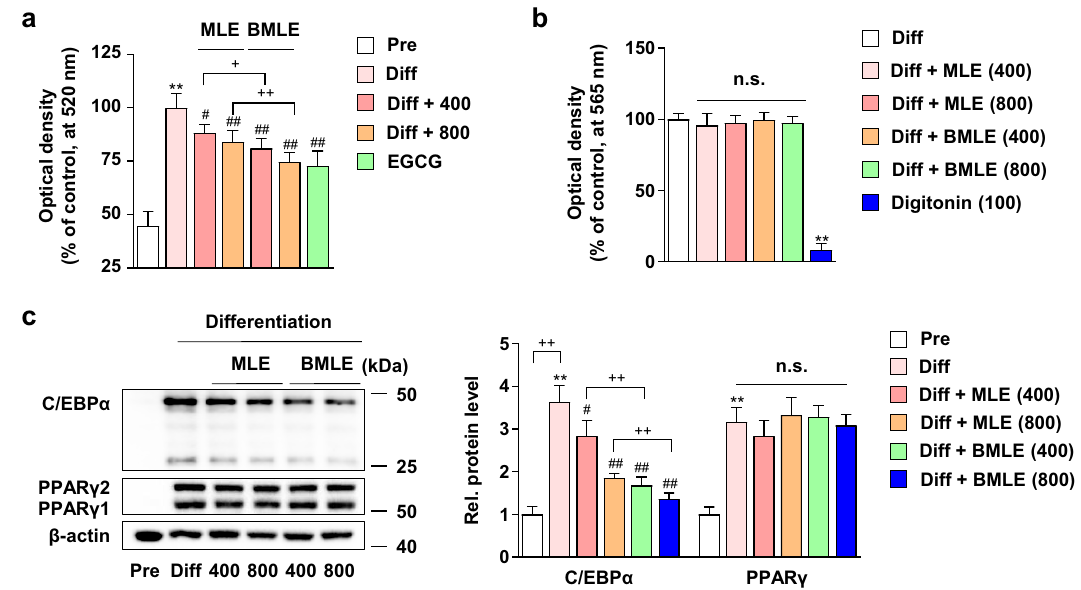
Figure 1. Effects of mulberry leaf extract (MLE) and bioconverted mulberry leaf extract with Pectinex (BMLE) on lipid accumulation, cytotoxicity, and adipogenic factors in 3T3-L1 cells. ( a ) Effects of MLE and BMLE on lipid accumulation in 3T3-L1 cells. MLE (400 and 800 μg/mL), BMLE (400 and 800 μg/mL) or (−)-epigallocatechin gallate (50 μM, EGCG) were treated 3T3-L1 adipocytes during differentiation periods. Oil red O staining was performed as described in the Materials and methods section. Pre: preadipocytes, Diff: 8-day differentiated cells. ( b ) Effects of MLE and BMLE on cytotoxicity in 3T3-L1 adipocytes. 3T3-L1 adipocytes were treated with MLE (400 and 800 μg/mL), BMLE (400 and 800 μg/mL) or digitonin (100 μg/mL, positive control for cytotoxicity). After 8 days of treatment, an MTT assay was performed. ( c ) Effects of MLE and BMLE on C/EBPα and PPARγ protein expression in 3T3-L1 preadipocytes and adipocytes. 3T3-L1 adipocytes were treated with MLE (400 and 800 μg/mL) and BMLE (400 and 800 μg/mL) for 8 days. ** P < 0.01 vs. Pre, # P < 0.05 and ## P < 0.01 vs. Diff, + P < 0.05 and ++ P < 0.01 vs. each group, n.s.; not significant. Data are presented as the mean ±